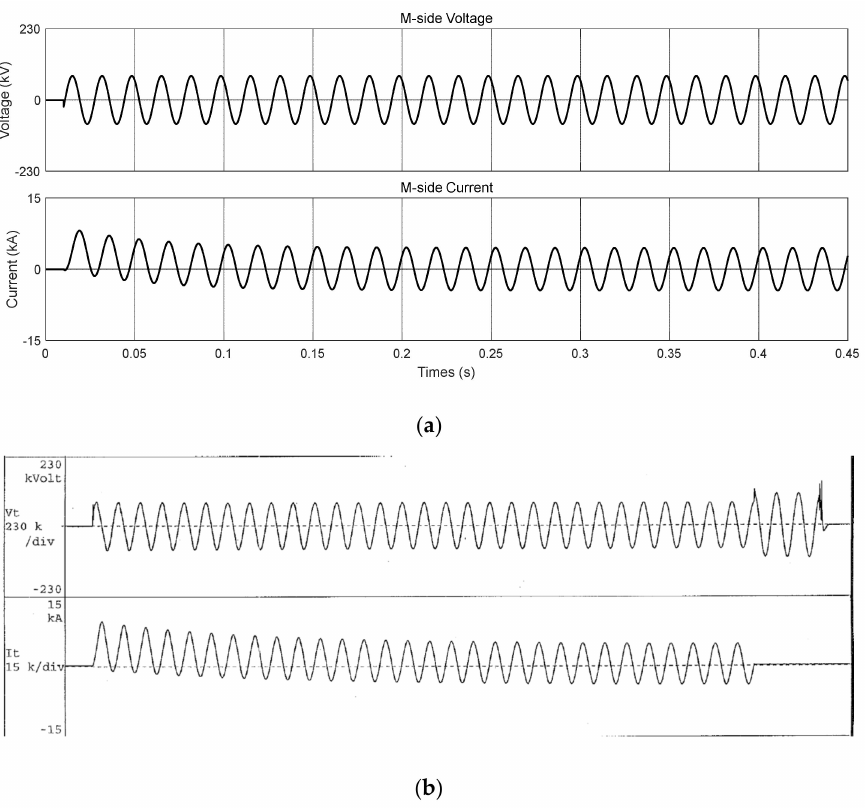
Figure 13. M-phase short-circuit test results of Scott transformer (comparison between short-circuit test results obtained by RTDS and those in the certified test report by KERI): ( a ) waveform of short-circuit test result of the proposed Scott transformer, obtained by RTDS simulation (M-phase); ( b ) waveform in the certified test report